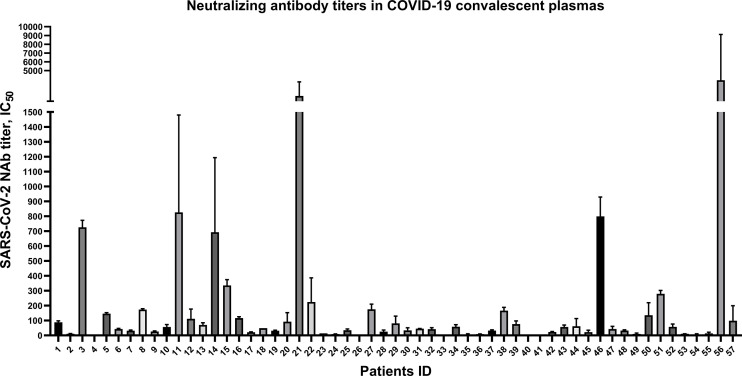
Highly variable neutralizing antibody titers of 57 convalescent plasmas from COVID-19 patients discharged in Zhejiang province from January to March in 2020. Plotted by IC50 mean with SD. Neutralizing antibody in 5 convalescent plasma samples were undetectable.